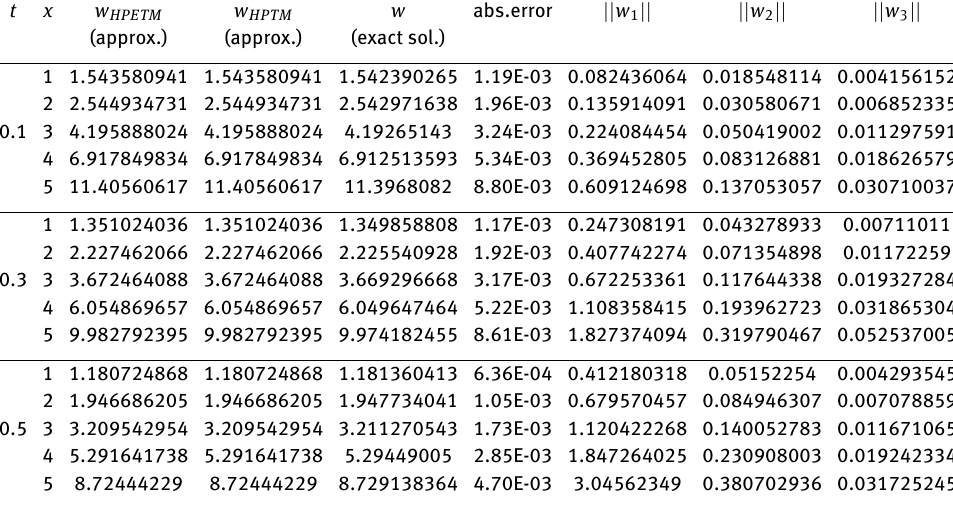
Table 2: Approximate solution of Fornberg-Whitham equation (6.4) and (8.4) up to fourth order (when α = 1